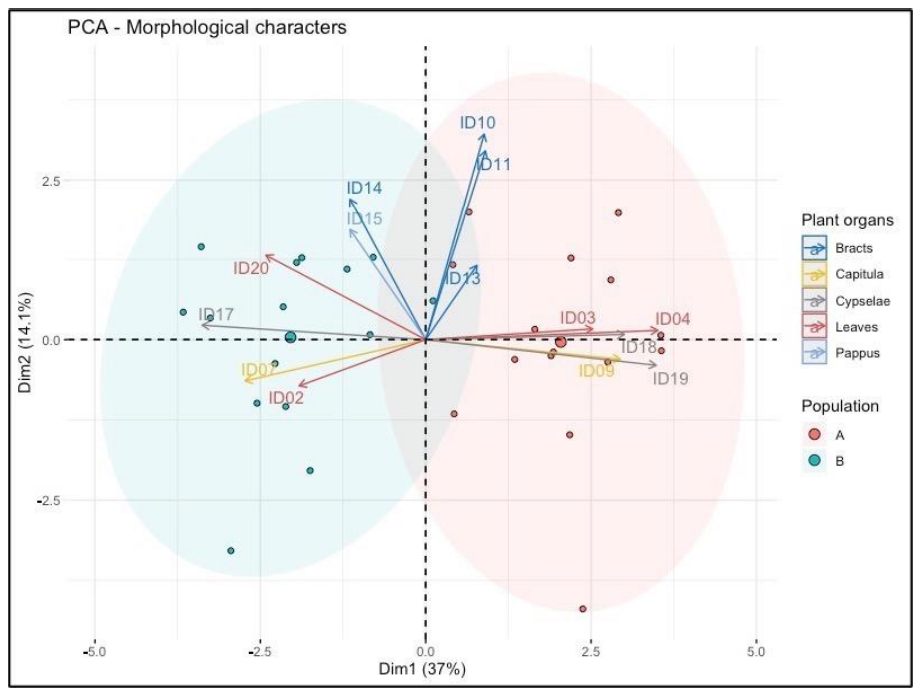
Figure 1. Principal component graph of morphological characters based on the first two components. H. litoreum is reported in population A, and H. italicum subsp. italicum in population B.